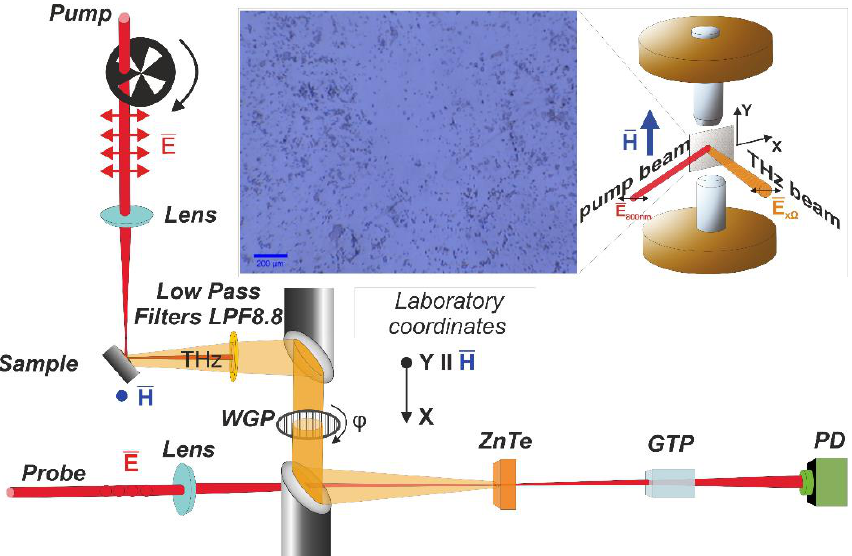
Figure 1. Schematic representation of the set − up, where WGP is the wire-grid polarizer, GTP is the Glan Taylor polarizer, and PD is the photodiode. Insets: optical micrograph of the sample and sample geometry in the magnetic field.